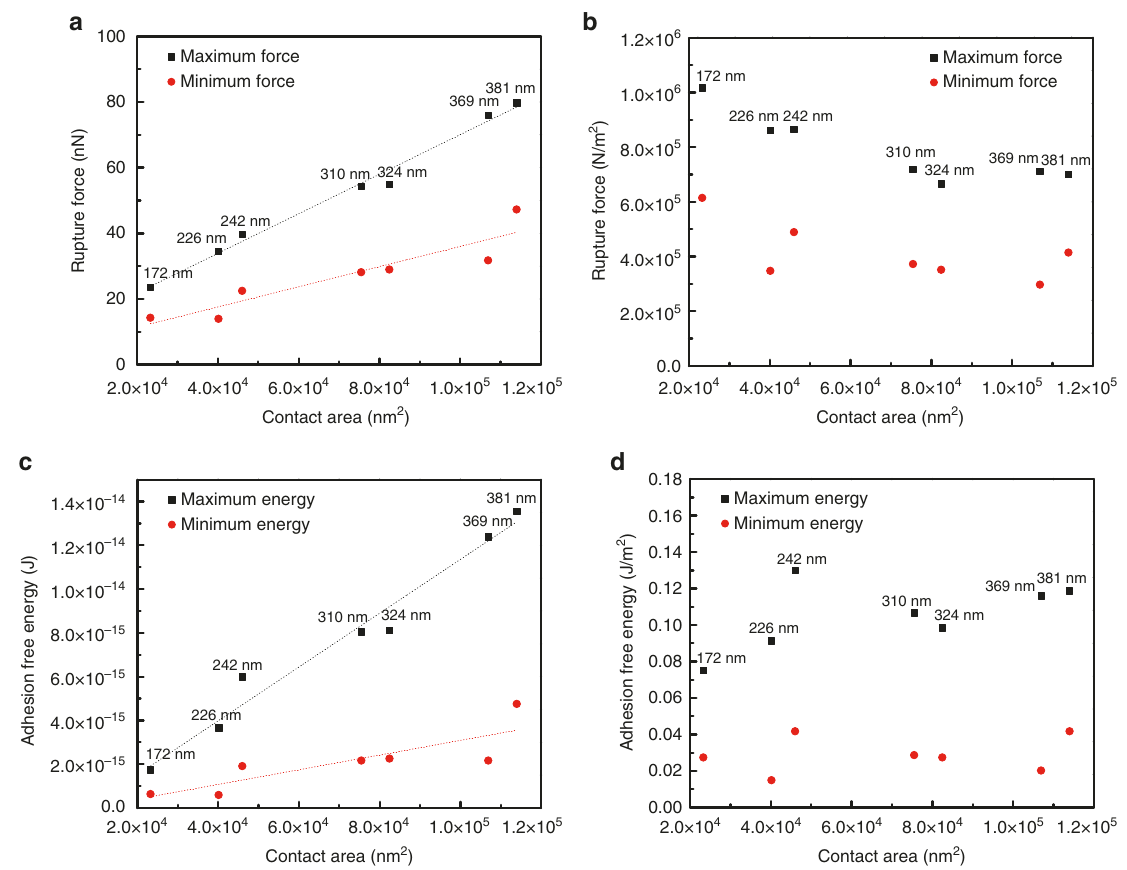
Fig. 3 Maximum and minimum rupture forces and adhesion-free energies of ZnO(0001) – ZnO(0001). a Force versus tip contact area; b force normalized to tip contact area; c the corresponding adhesion-free energy versus contact area; d adhesion-free energy normalized to tip contact area. Tip diameters are